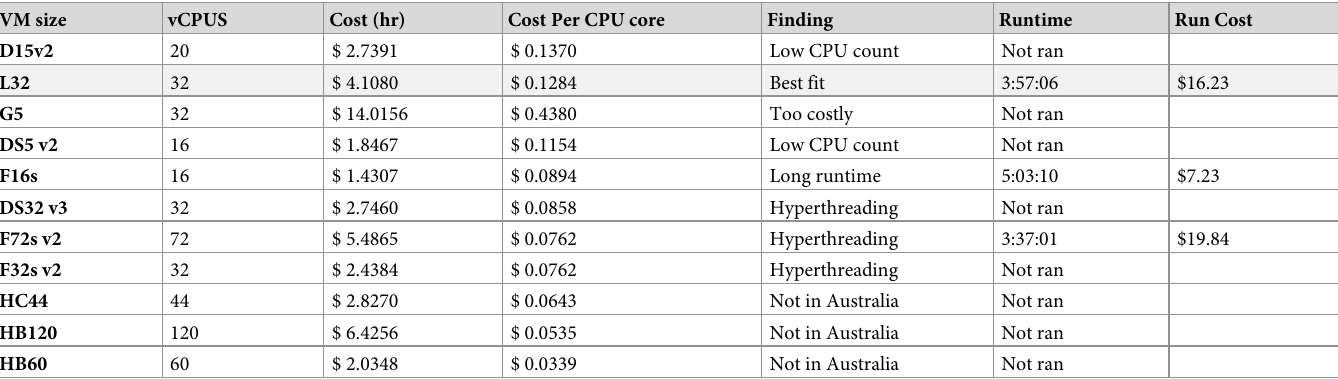
Table 2. CPU VMs that were tested in the